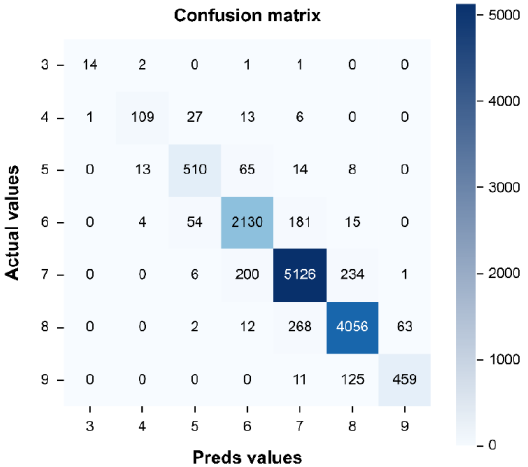
Figure 5. Deck confusion matrix result for the test data.